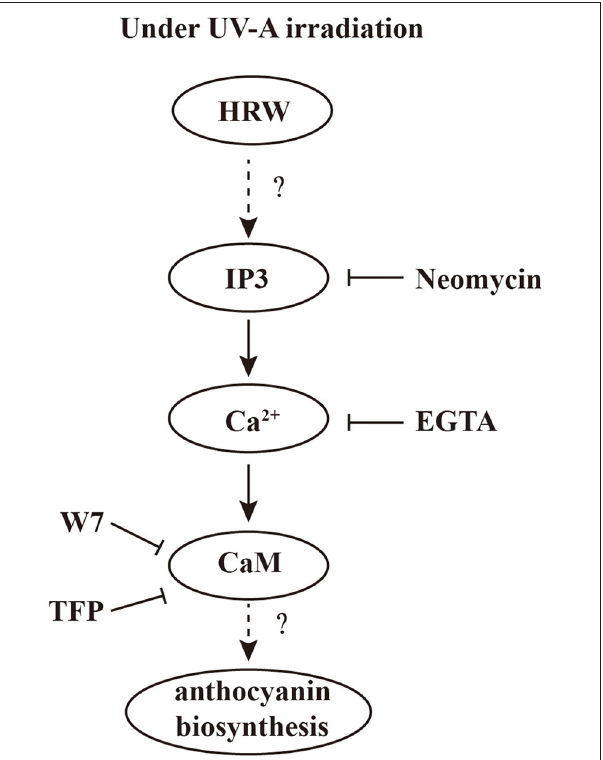
FIGURE 7 | A proposed model of calcium involving in HRW-promoted anthocyanin biosynthesis under UV-A in radish sprouts hypocotyls. Under UV-A irradiation, HRW could promote the generation of IP3, which bound to the IP3 receptors of the calcium stores, and thus the concentration of cytosolic Ca 2 + increased. Afterwards, calcium receptors CaM could activate the expression of anthocyanin biosynthesis-related genes to promote anthocyanin